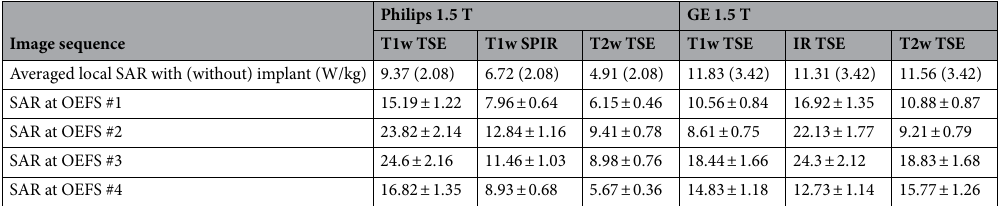
Table 1. Experimentally measured SAR (mean ± SD) using four optical E-field sensors at Philips 1.5 T and GE 1.5 T MRI systems and the average of the local SAR measurements with and without artificial hip joints at all locations from the head to the tail of the implants. The local SAR values were obtained from temperature sensors. OEFS = optical E-field sensors, SD = standard deviation, SPIR = spectral pre-saturation with inversion recovery, TSE = Turbo spin echo.